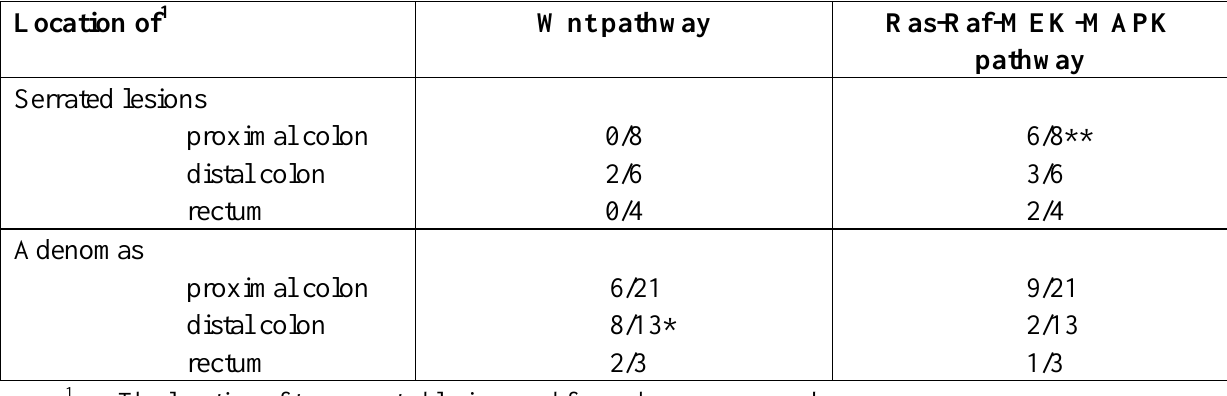
Table 4. Anatomical location of the colorectal lesions with an altered Wnt or Ras-Raf- MEK-MAPK